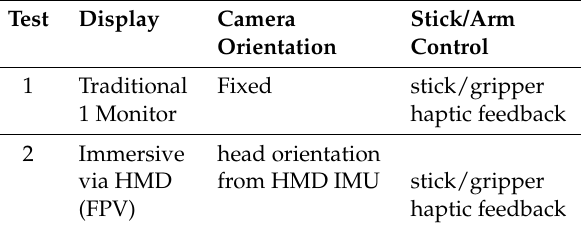
Table 2. The two different test setup combinations for semi-teleoperation tasks. Fixed view, first-person view